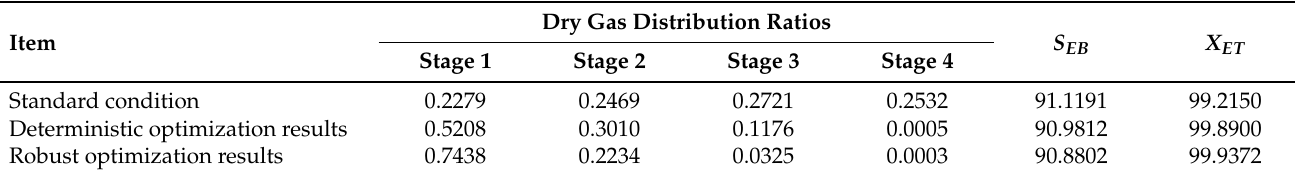
Table 5. Standard condition and multi-objective optimization